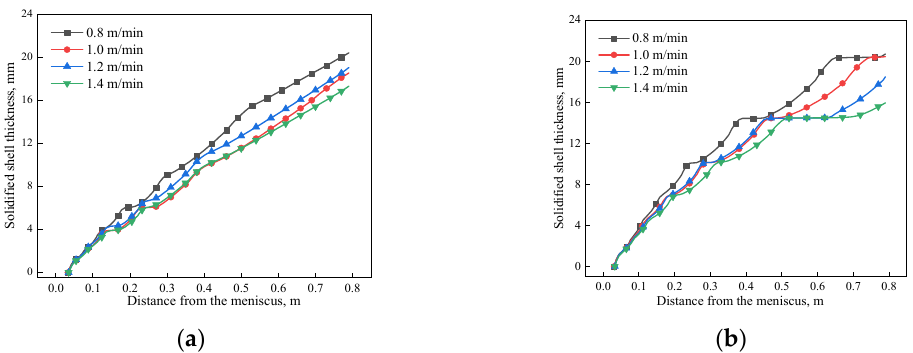
Figure 13. Variation of the solidified shell at the center of, ( a ) wide face, ( b ) narrow face under different casting speeds at (600 A, 4 Hz).